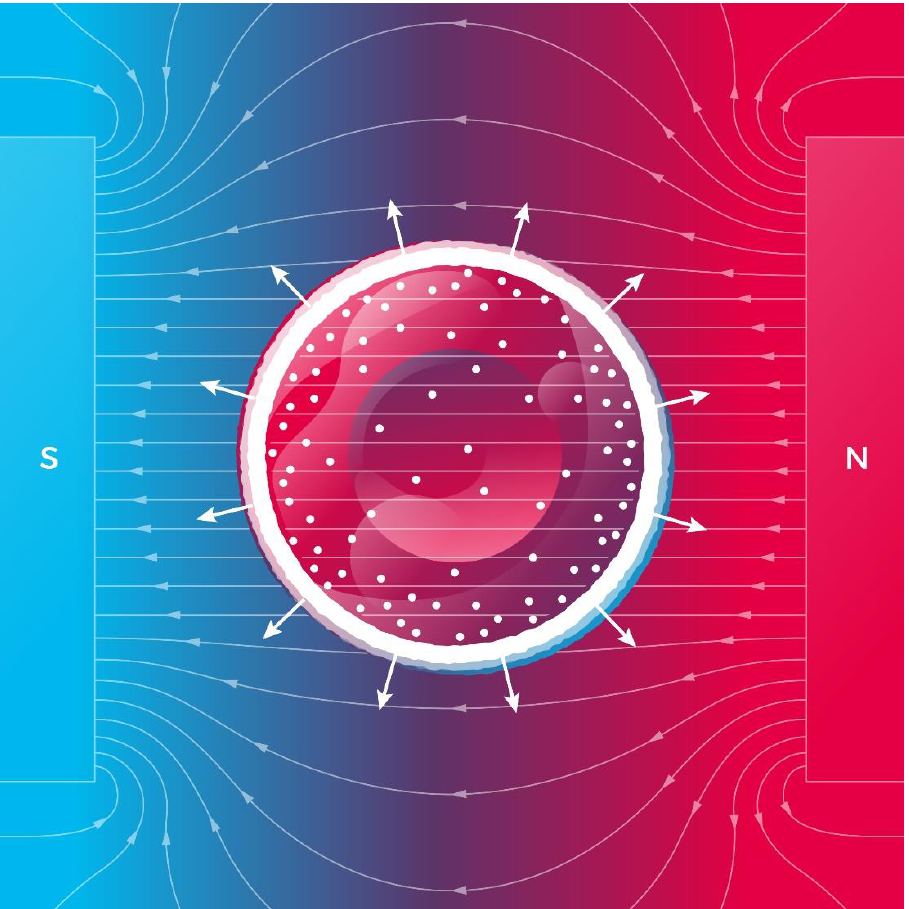
Figure 3. Scheme of a deoxygenated red blood cells under magnetic pressure on deoxyHb. The white radial arrows show directions of the magnetic concentration-gradient forces. Small white circles represent deoxyHb molecules, while the large white circle represents a layer of absorbed deoxyHb on the inner surface of the membrane of an RBC.